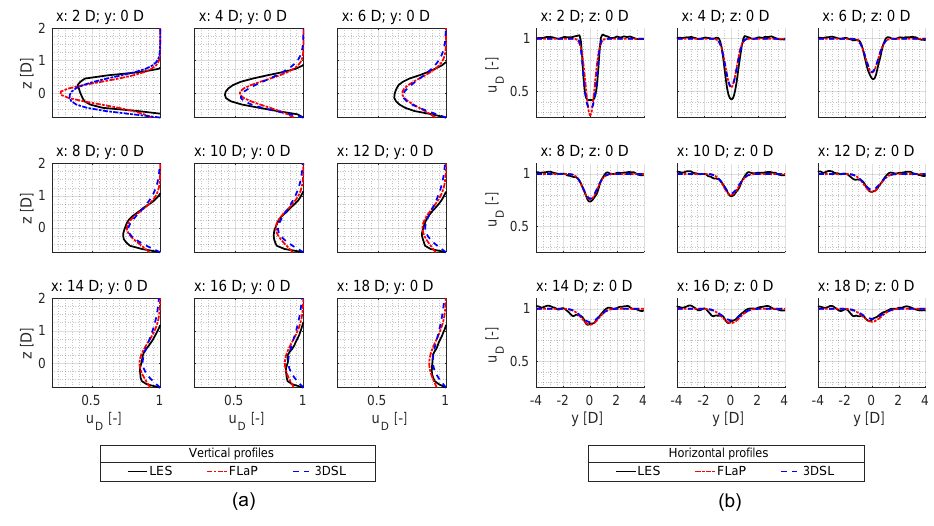
Figure A1. Test case 1 (single wake). Downstream development of the vertical (a) and horizontal (b) profiles of the wake velocity evaluated along the wind turbine rotor axis from the 3DSL model and from the FLaP simulations and from the reference large-eddy simulation (LES) wind